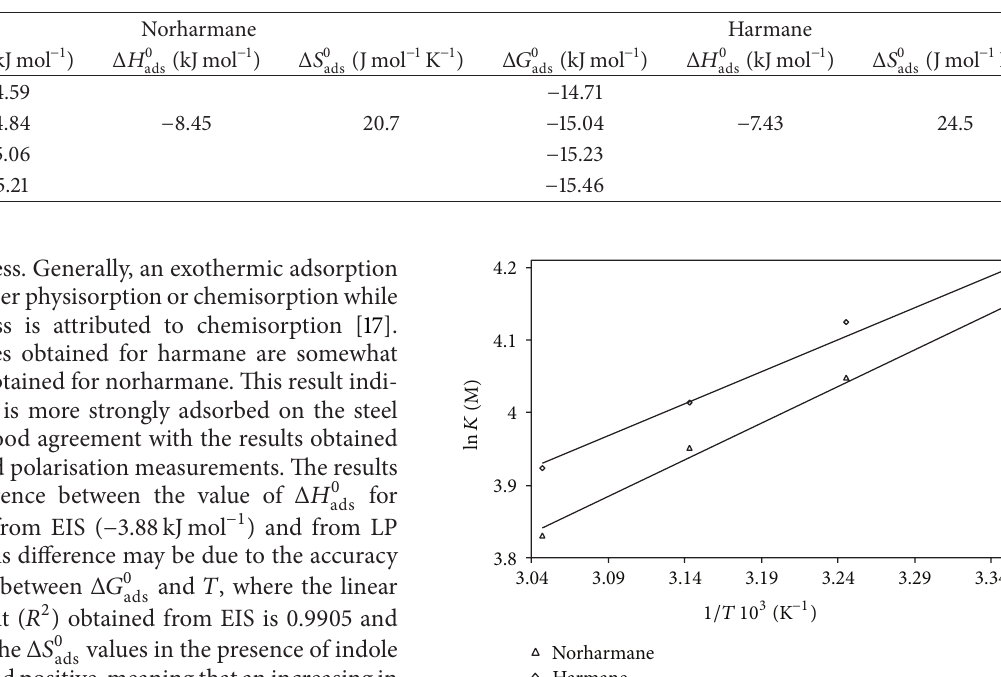
Table 8: Thermodynamic parameters calculated from LP for the adsorption of indole derivates on C38 steel in 1M HCl at different temperatures.